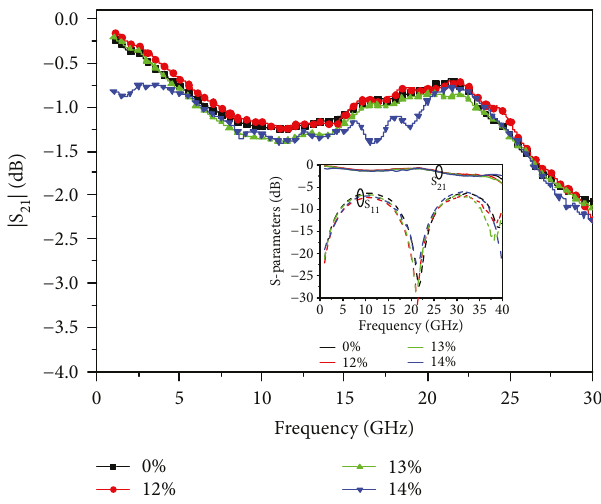
Figure 2: Insertion loss and S-parameters (inserted fi gure) of silver lines at various torque